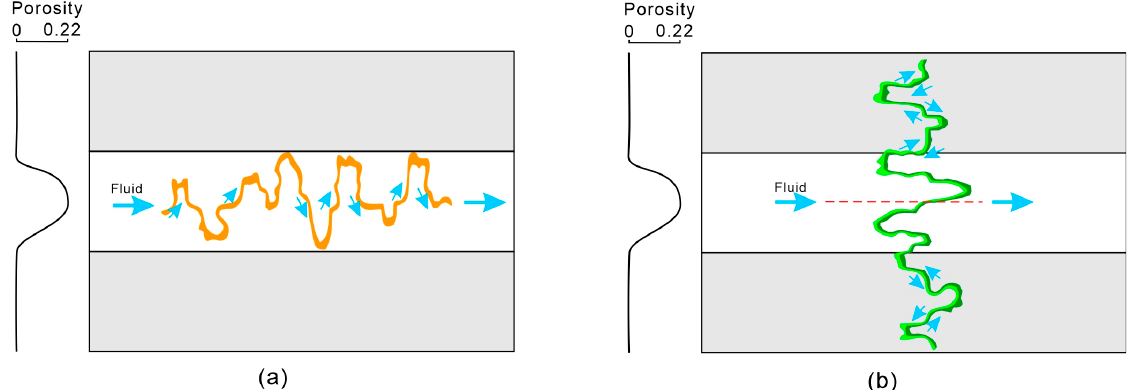
Figure 14. Effect of porosity on different dip angle stylolites. ( a ) Effect of porosity on low ‐ angle stylolites. ( b ) Effect of porosity on high ‐ angle stylolites.